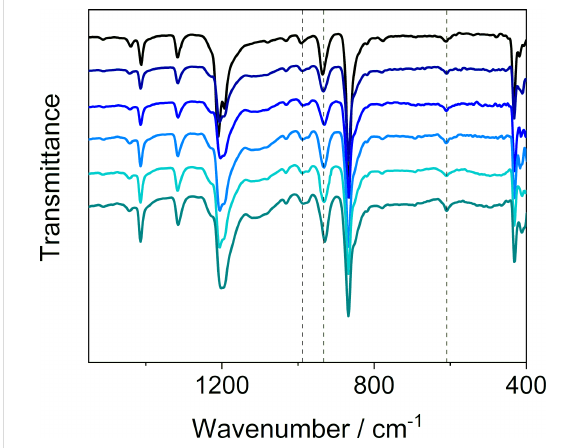
Figure 7: FTIR spectra of MFU-4 loaded with SF 6 (Sample 3a) after 0, 1, 3, 7, 14, and 60 days. Bands attributed to SF 6 are marked with dotted vertical lines.